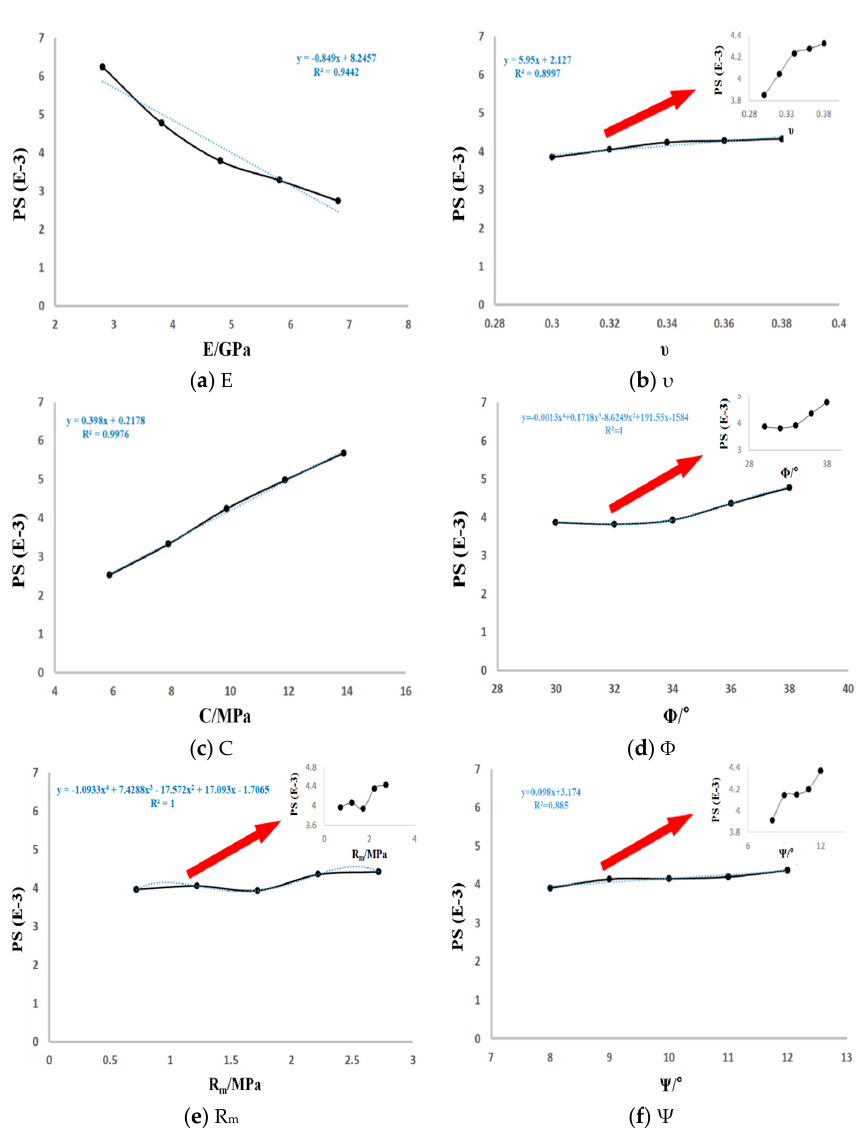
Figure 14. Influence of variation in each parameter on peak strain sensitivity.